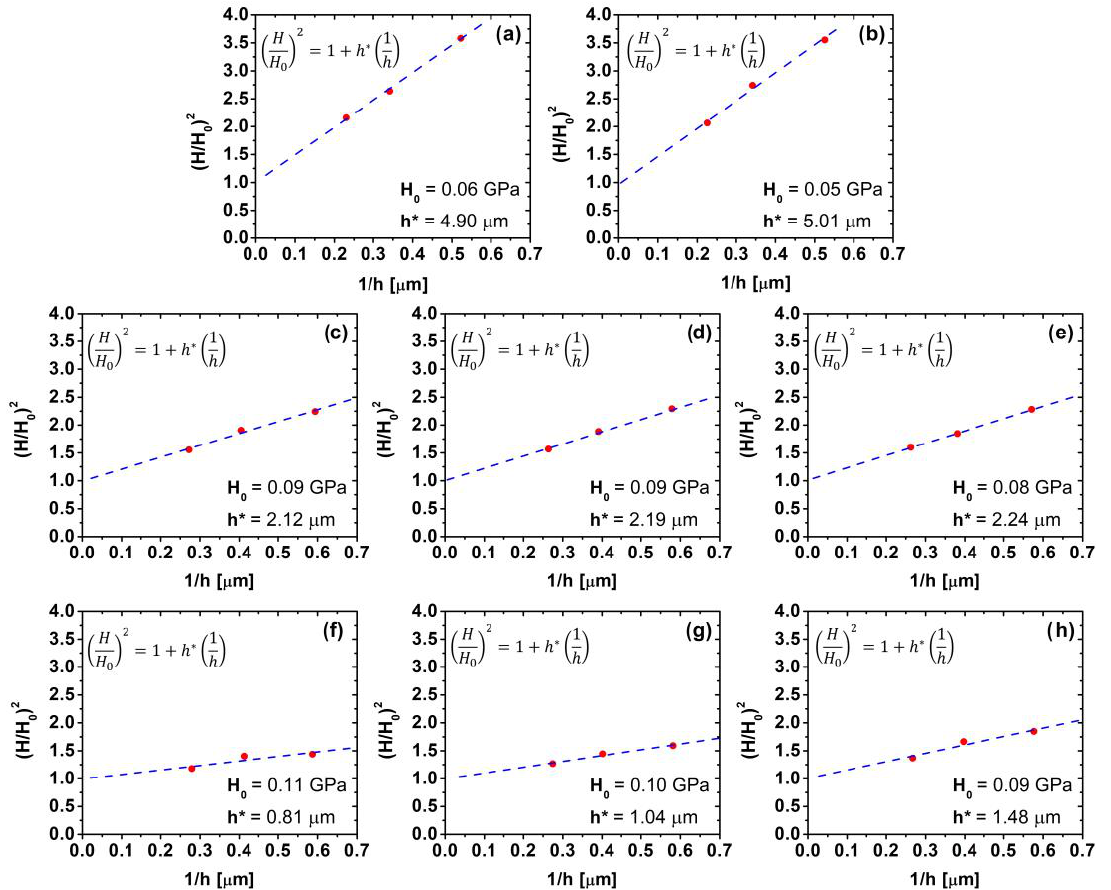
Figure 5. Data of micro-indentation measurements for the undeformed spheres at the ( a ) surface and ( b ) core; compacted spheres at 196 MPa at the ( c ) perpendicular contacts, ( d ) parallel contacts and ( e ) core; compacted spheres at 500 MPa at the ( f ) perpendicular contacts, ( g ) parallel contacts and ( h ) core.